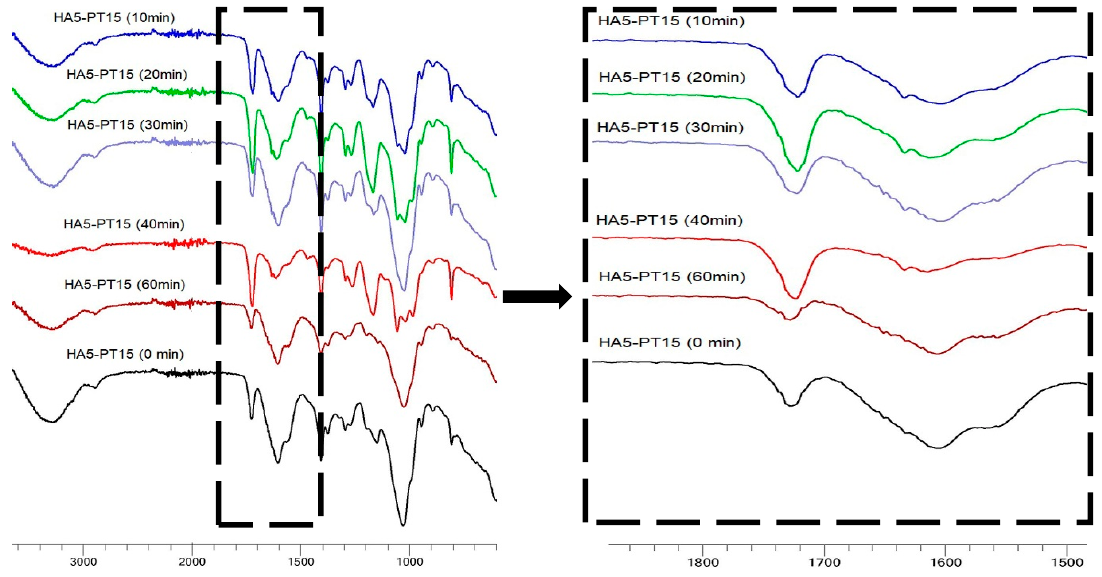
Figure 9. HA5-PT20 crosslinked by microwave irradiation (x-axis is the wavenumber/cm − 1 ). At 30 min, the C=C in the acrylate group, which is around 1,640 cm − 1 was preserved.